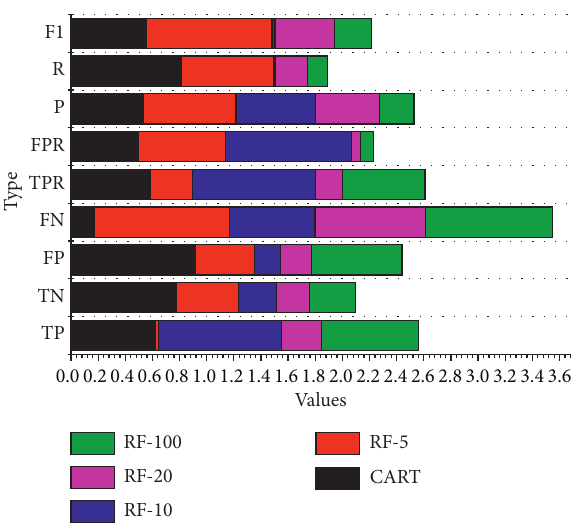
Figure 7: Performance comparison of CART and RF classifiers. Table 1: Test